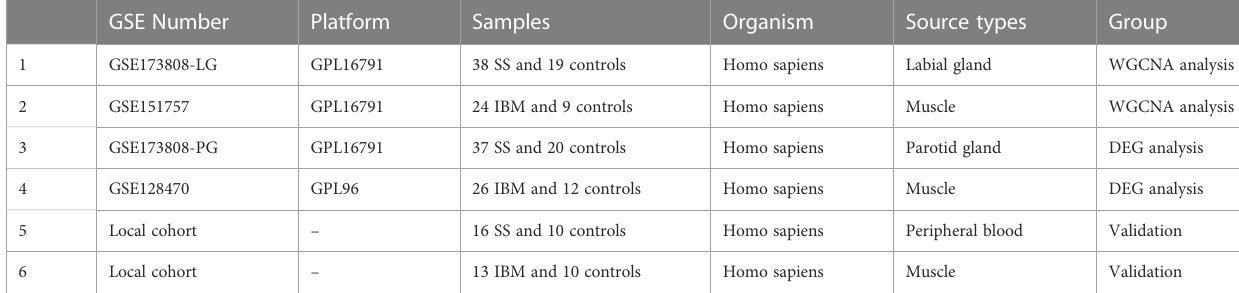
TABLE 1 Detailed information of GEO datasets containing the SS and IBM patients.